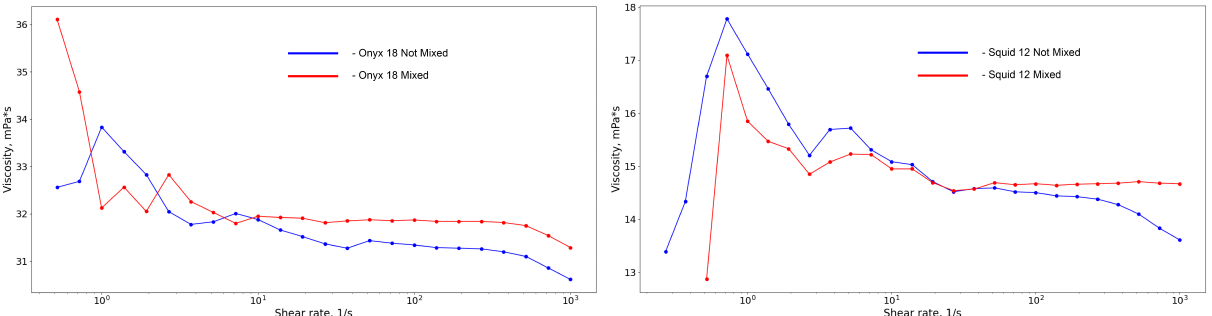
Figure 5. Experimental data of the viscosity dependence on shear rate of Onyx (cid:114) ( left ) and Squid (cid:114) ( right ) mixed and not mixed with tanthalum